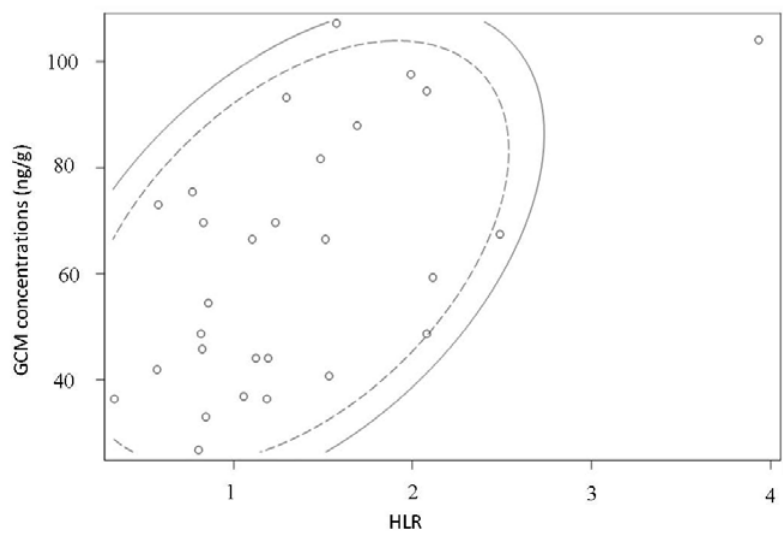
Figure 3. Scatter plot displaying the relationship between individual droppings GCM concentrations